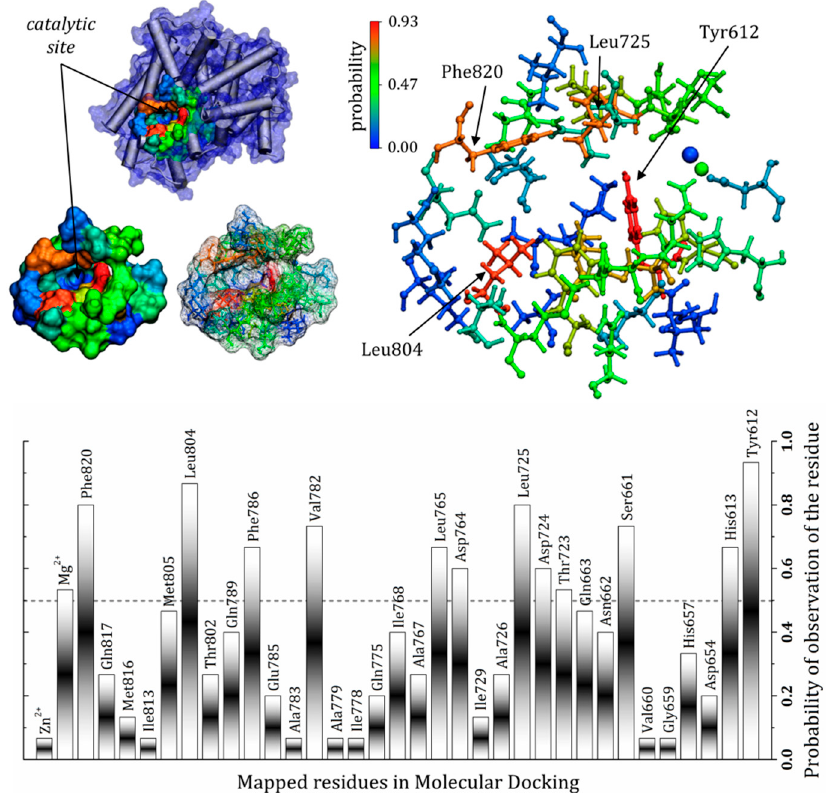
Figure 7. Amino acid residues identified as important for stabilization of the commercial PDE5 inhibitors, showing the frequency of observation of the residues as a probability. The probability values were obtained by the number of observations considering all the inhibitors and the three structures used in the molecular docking study. Residues were r ≤ 3.0 Å from the ligand.